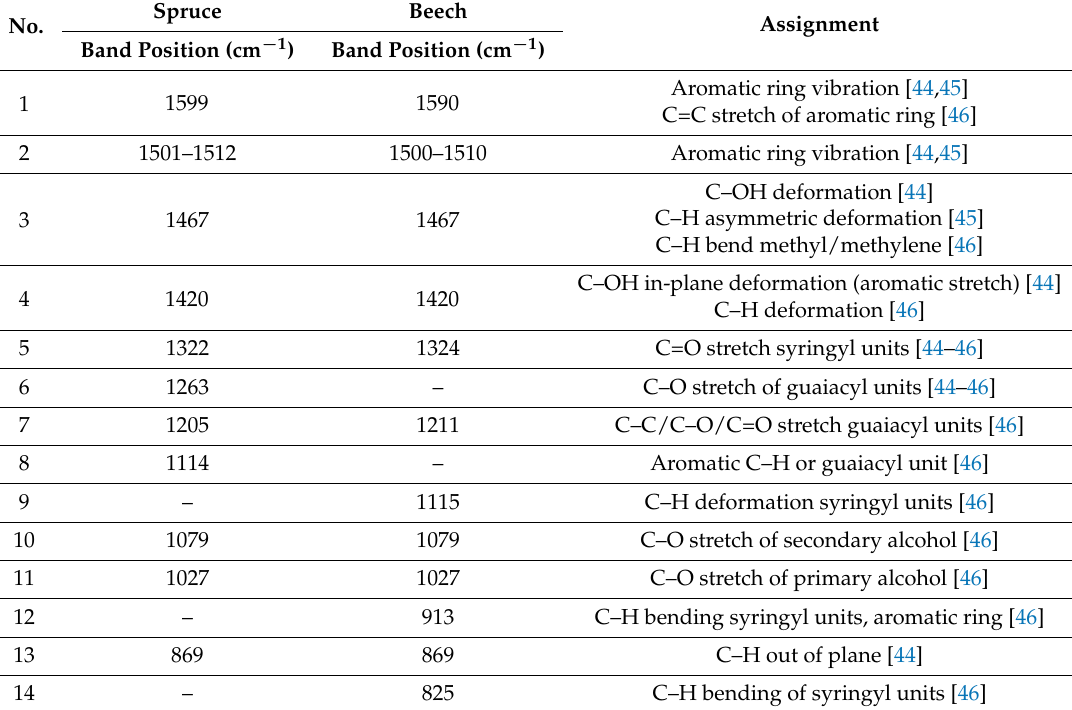
Figure 1. Atomic force microscopy (AFM) topographical images of spin-coated lignin samples on polished stainless steel 316L. Beech before ( a ) and after ( b ) annealing, and spruce before ( c ) and after ( d ) annealing. Table 2. Summary of infrared (IR) bands and assignments for spruce and beech coatings in fourier transform infrared spectroscopy (FTIR) fingerprint region (800–1800 cm − 1 ).